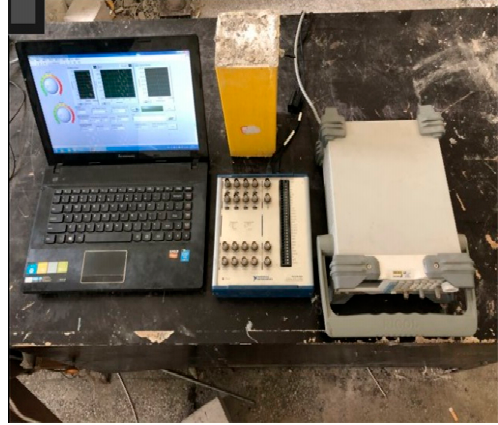
Figure 7. Picture of monitoring system.